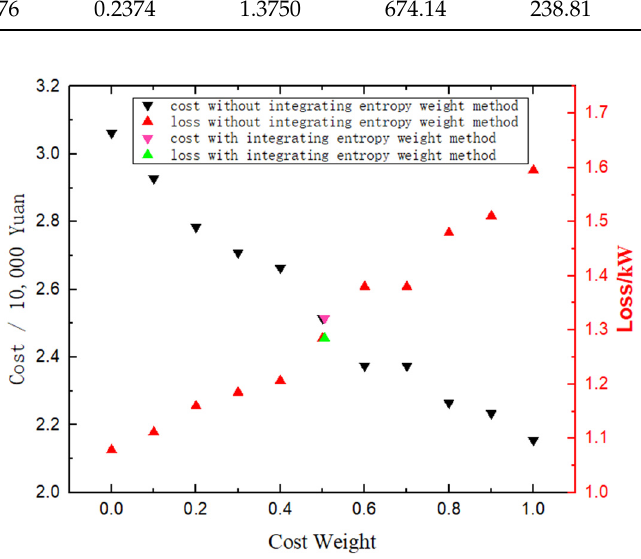
Figure 9. The cost and loss with/without integrating entropy weight method.